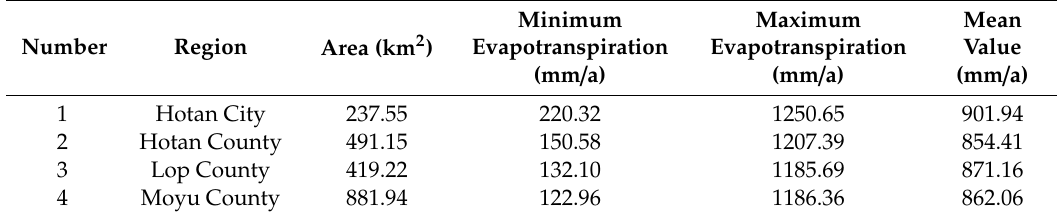
Table 2. The evapotranspiration of farm land in di ff erent regions in